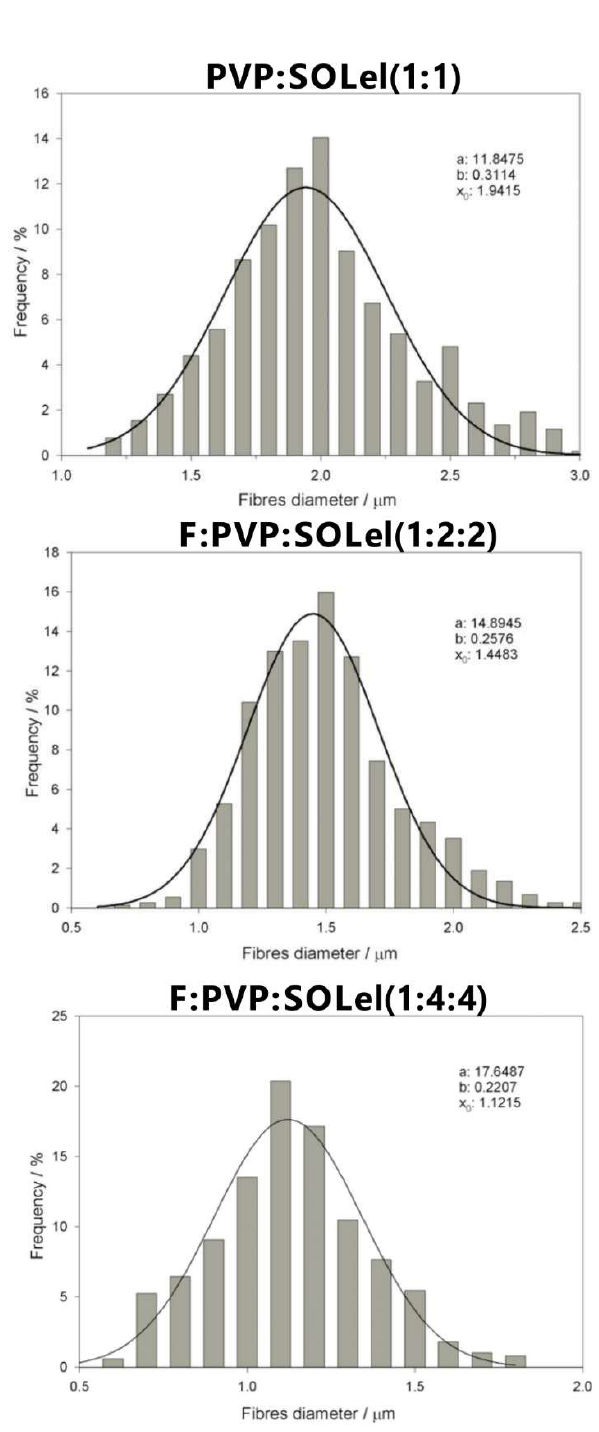
Figure 3. Histogram of the fiber size distribution and curve of the normal-log distribution, mean value, SD, and regression coefficient for PVP:SOLel (1:1), F:PVP:SOLel (1:2:2), and F:PVP:SOLel (1:4:4). As an example, in Figure 4, the DSC curves of the pure drug and of the samples PVP:SOL (1:1), F:PVP:SOL (1:2:2), and F:PVP:SOL (1:4:4) are Table 2. Percentile values of the electrospun fiber diameters: d(0.1), d(0.5), and d(0.9) are the fractions of fibers with the reported size or lower.